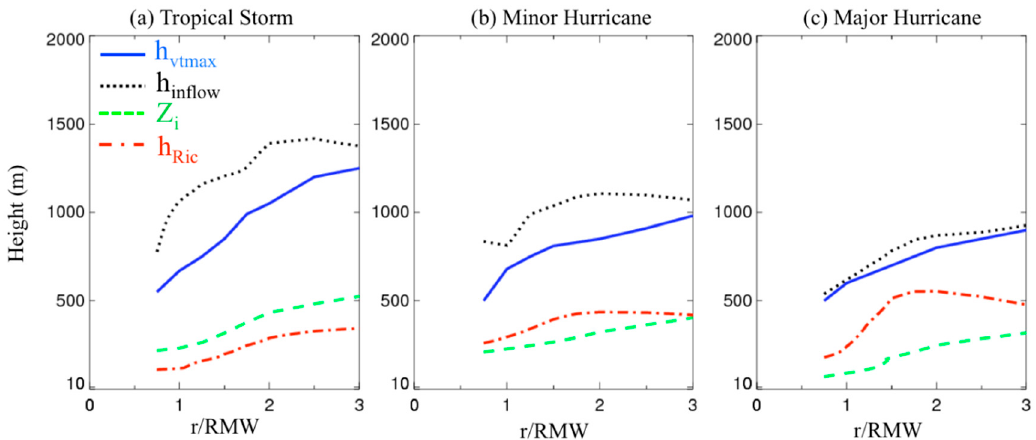
Figure 14. A schematic plot summarizing the height scales in the composites of ( a ) tropical storms, ( b ) minor hurricanes, and ( c ) and major hurricanes. Note that h vtmax is the height of maximum tangential wind speed; h inflow is the inflow layer depth, Z i is the thermodynamic mixed layer depth, and h Ric is the boundary layer height based on critical Richardson number method.